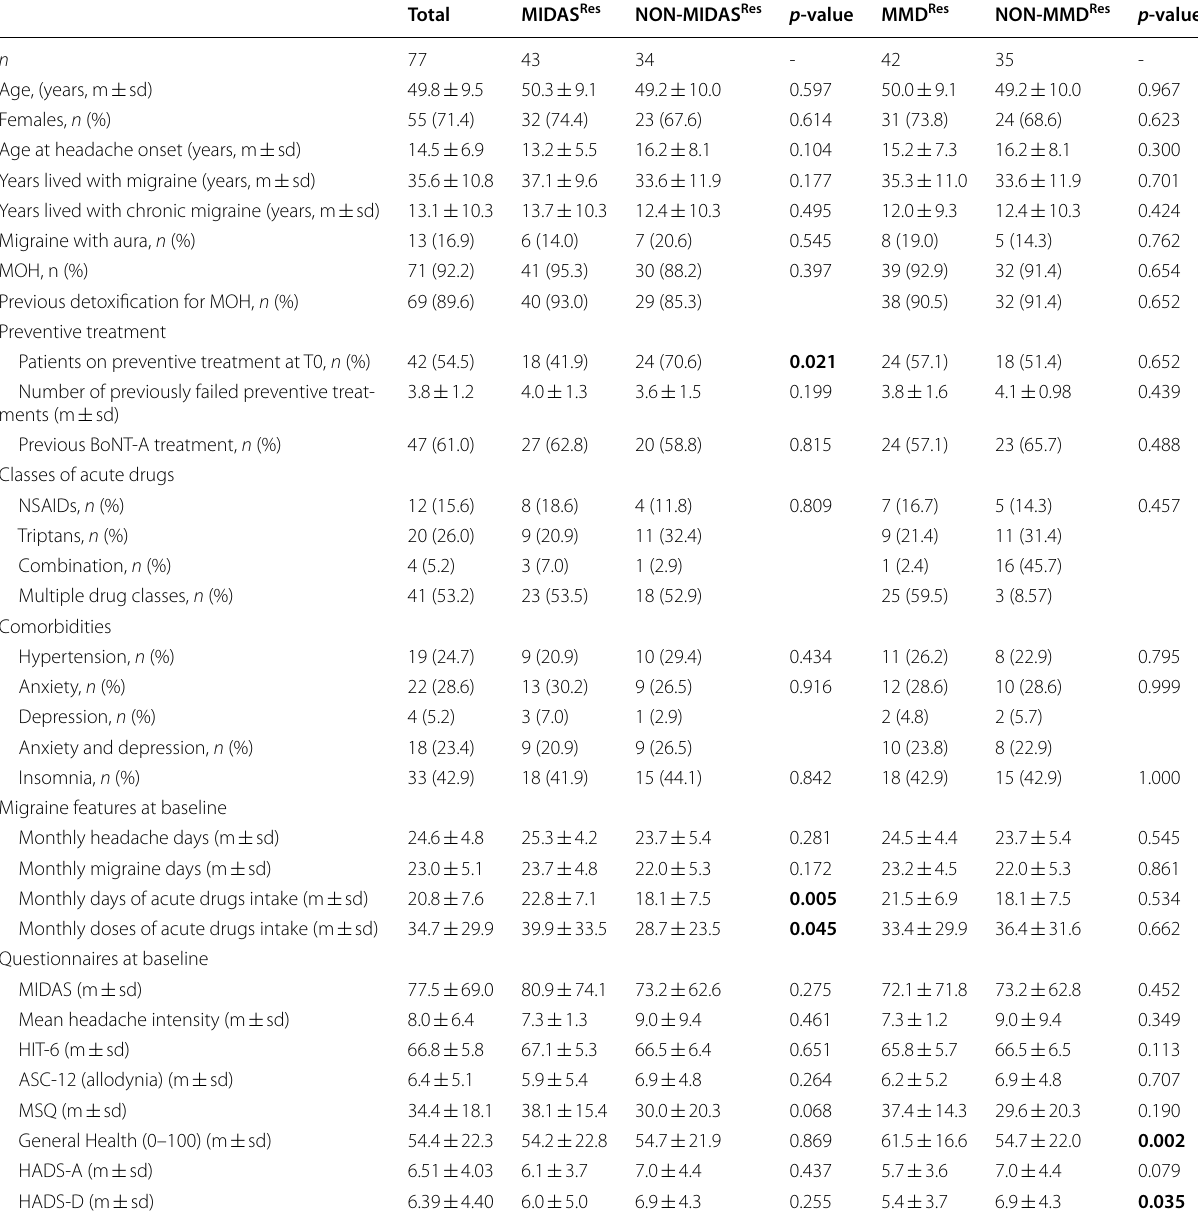
Table 1 Clinical and demographic features of study population, and comparison between MIDAS Res / NON-MIDAS Res and MMD Res / NON-MMD Res